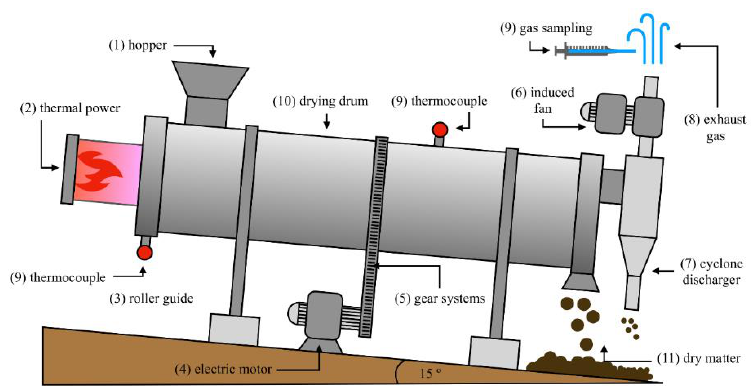
Figure 1. Biomass drying trommel. (1) hopper; (2) thermal power; (3) roller guide; (4) motor; (5) gear systems; (6) induced fan; (7) cyclone discharger; (8) exhaust gas; (9) thermocouple; (10) drying